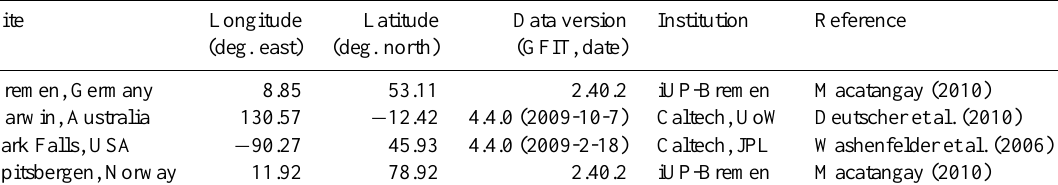
Table 1. Overview of FTS sites.